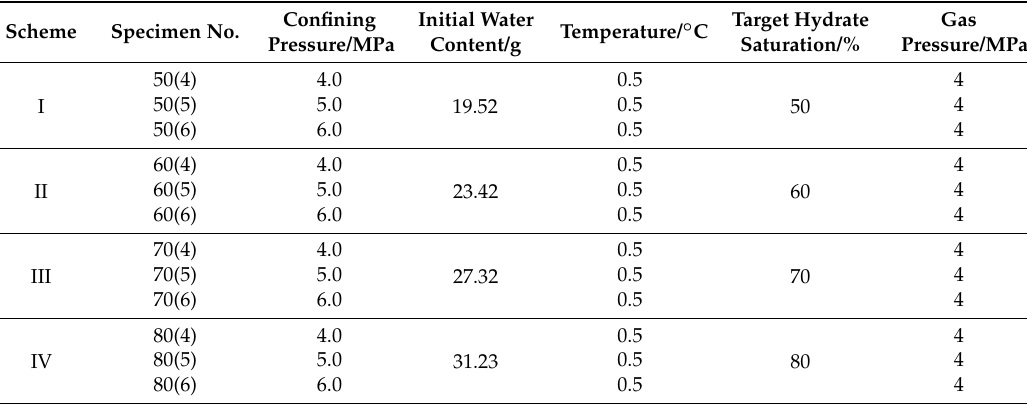
Table 2. Experimental